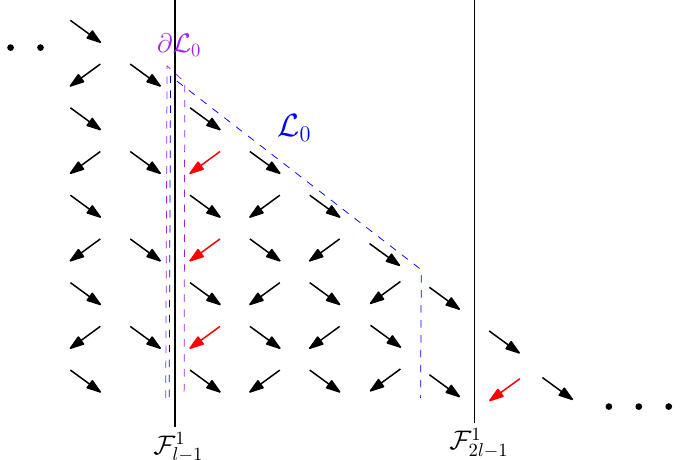
Figure 5. Region L 0 , highlighted with blue dashed lines, is a 2nd strip for l = 5. Its boundary ∂ L 0 is a set of points in the left filter restriction F 1 , which is highlighted with purple dashed lines. l − 1